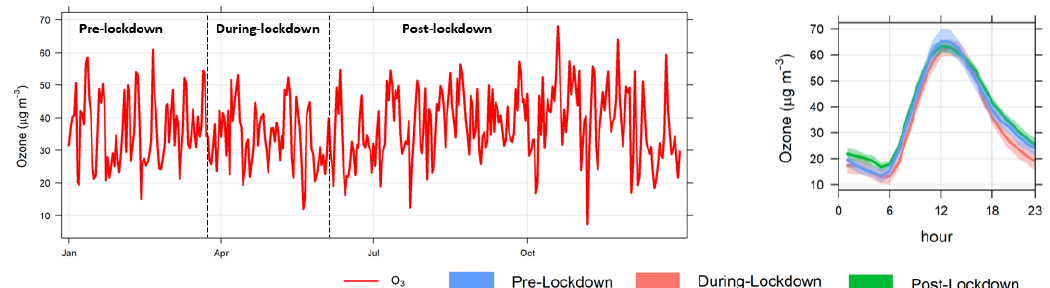
Figure 8. The variation in 24 h concentrations and hourly diurnal profile of ozone at Rocklea mon- monitoring station for different itoring station for different periods.